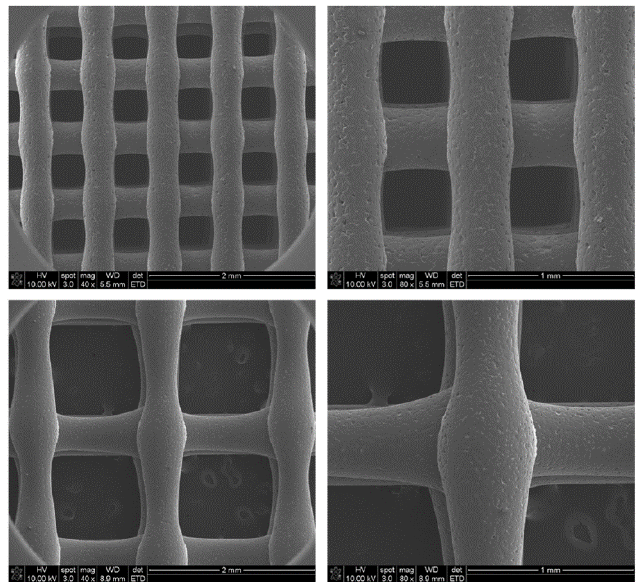
Figure 1. Characterization of scaffold using SEM analysis. SEM images of polycaprolactone ( PCL) scaffolds (upper: 400/400 scaffold, lower: 400/1200 scaffold) (original magnification: Left, ×40; Right, × 80). Picture taken from Park et al. [59] under the terms and conditions of the Creative